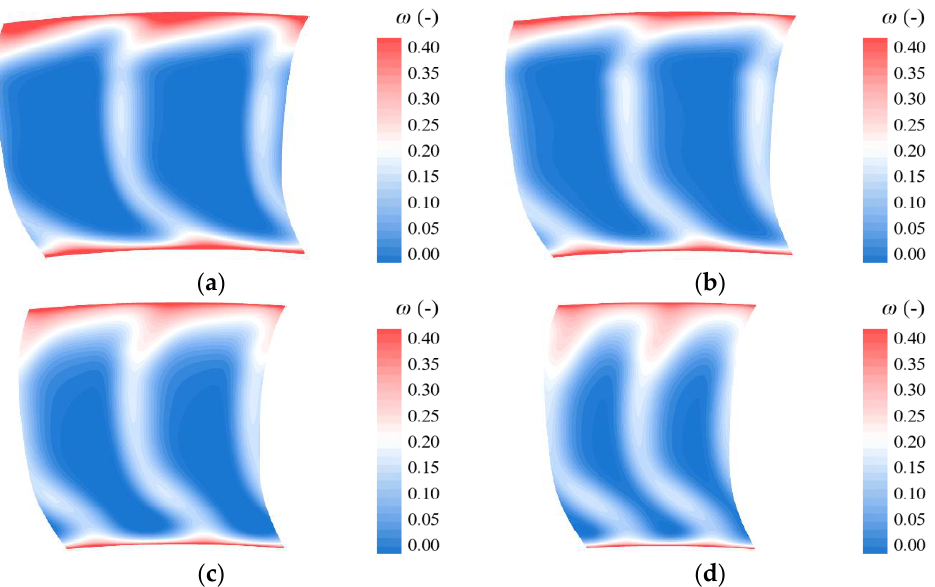
Figure 23. The distribution of total pressure loss at stator outlet for the design point: ( a ) ψ = 0.41; ( b ) ψ = 0.47; ( c ) ψ = 0.55; ( d ) ψ = 0.65.